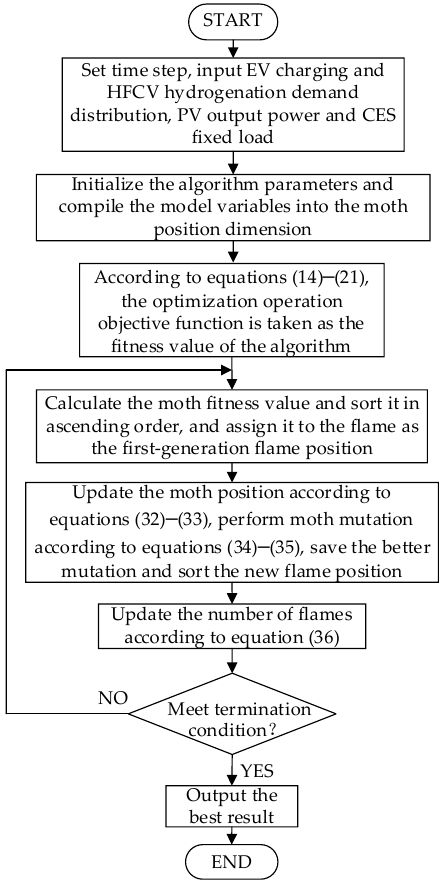
Figure 3. CES optimization operation solution flow chart.